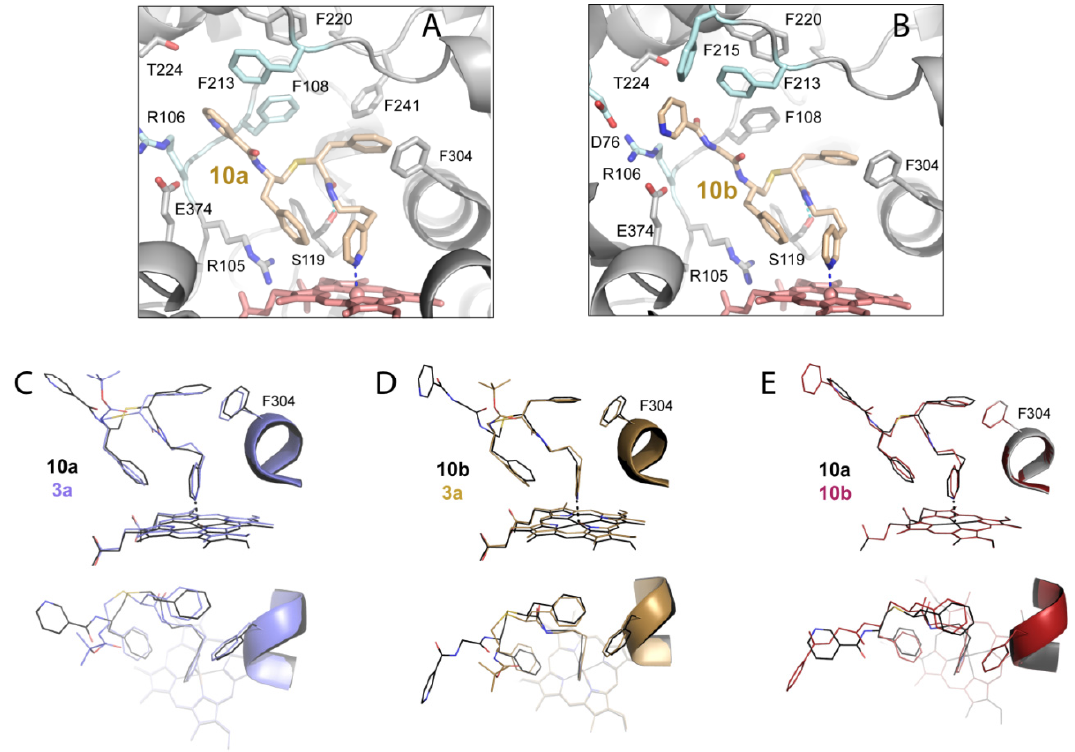
Figure 8. Interactions mediated by 10a – b in the CYP3A4 active site ( A , B ) and comparison of the 10a – 3a I, 10b – 3a ( D ), and 10a – 10b pairs ( E ). ( A , B ) 10a and 10b bind in a traditional orientation and place the end-pyridine into the substrate access channel. Because of the longer R 2 –R 3 linker in 10b , its end-pyridine inserts further into the channel and cannot orient optimally for π – π and cation– π interactions with Phe215 and Arg106. Among series-VI inhibitors, only 10a , b formed S– π interactions with Phe108 via the backbone sulfur atom. ( C – E ) The side and top views of structural overlays (upper and lower panels, respectively) show only small positional differences in the backbone and side-group orientations caused by R 3 -pyridine attachment. No notable changes in Phe304 were observed as well. The CYP3A4- 3a complex structure used for comparison has the PDB ID code 7KVH.